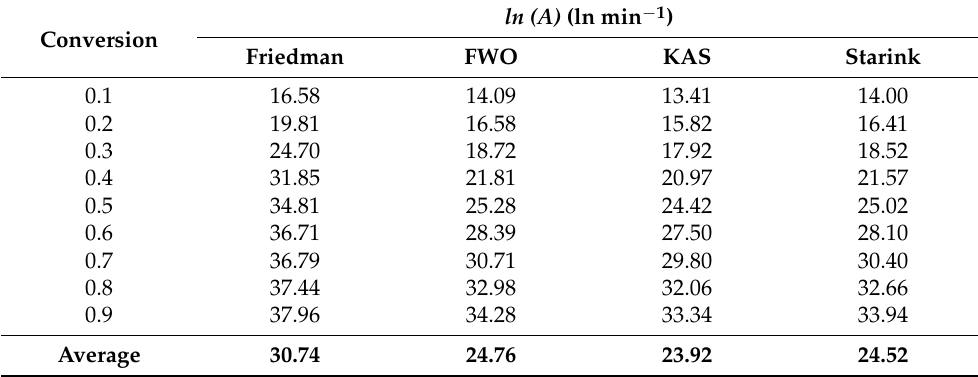
Table 9. Pre-exponential factor of the co-pyrolysis of PS and PP (tests